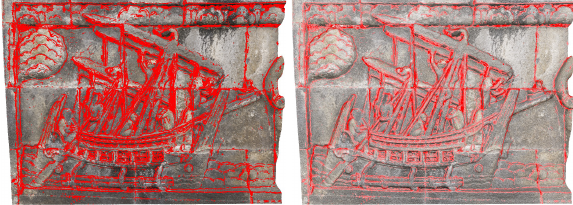
Figure 15. Comparative visualizations of the Borobudur relief (2): The left image is created by the conventional opaque point-based rendering and the right image by SPBR with the opacity-based edge highlighting (type (c)).